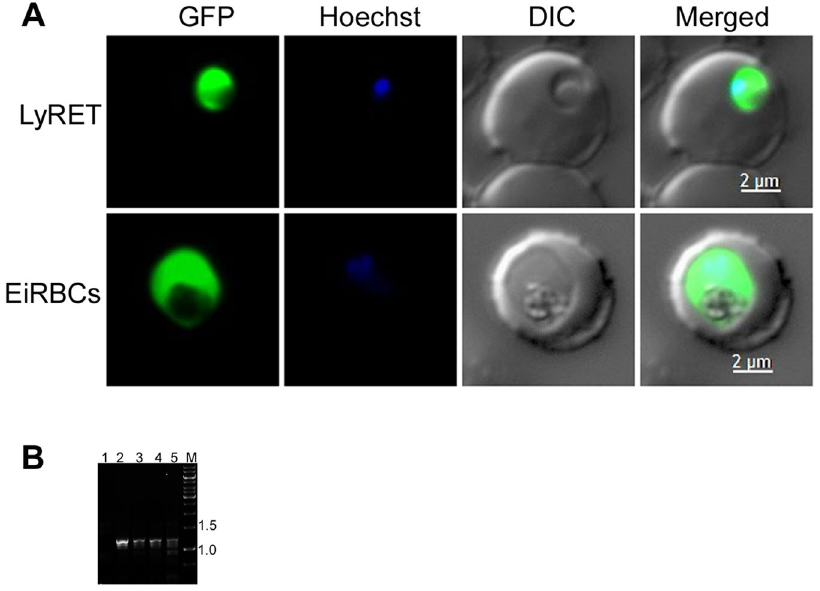
Figure 3. ( A ) GFP expression in drug resistant parasites. P. falciparum 3D7 was transfected with pFCEN1 using LyRET and EiRBC methods. Drug resistant parasites were evaluated for GFP expression using live cell fluorescence microscopy. Shown are images for GFP expression (GFP), nuclear stain (Hoechst), bright field (DIC) and the overlap of all images (Merged). ( B ) The presence of HFDDI in parasites. P. falciparum 3D7 was transfected with HFDDI using LyRET and EiRBC methods. The presence of HFDDI in drug resistant parasites was determined by PCR amplification of P. yoelii α -tubulin region of the plasmid from the total DNA. The